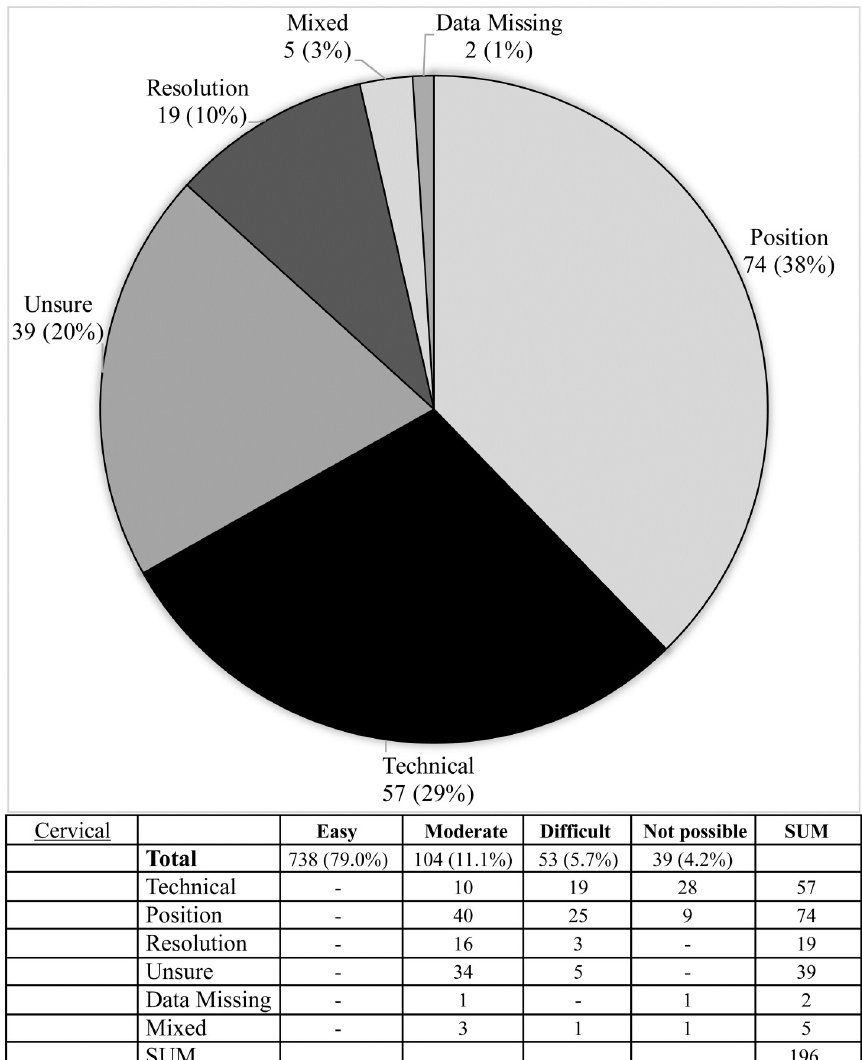
Fig 9. Difficulties reported during image assessment of the cervical method. Difficulties were grouped as those due to technical difficulties e.g. landmark(s) lying outside of the edge of the image; resolution issues, insufficient resolution to assess image easily; positioning—landmark not visible, or not clearly visible due to limb rotation or shadowing; and if rater was ‘unsure’ due to problems with method